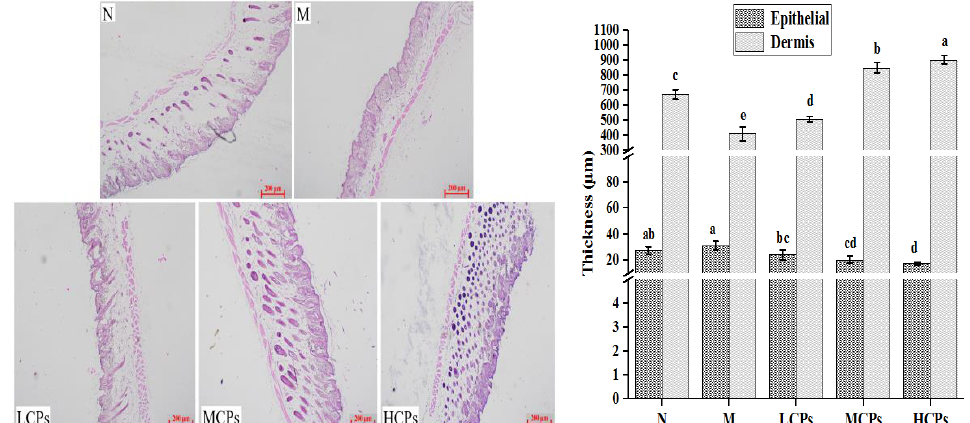
Figure 2. Effect of CPs on the histomorphology of aged skin ( n = 3). Di ff erent letters in the same column indicate significant di ff erences ( p < 0.05), the same below. N — Normal group; M — Model group; LCPs — Low dose collagen peptide group; MCPs — Medium dose collagen peptide group; HCPs — High dose collagen peptide group. The same below.